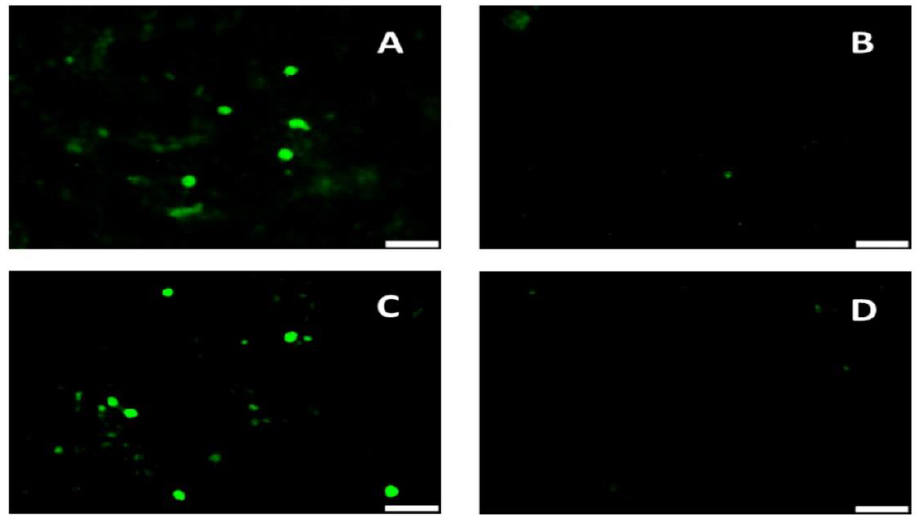
Figure 2. Rescue of the recombinant rPCV2-Vac. ( A ) PK-15 cells transfected with the rPCV2-Vac construct and stained with a PCV2 specific polyclonal antibody ( C ) PK-15 cells transfected with the rPCV2-Vac construct and stained with a Neospora caninum specific polyclonal antibody. ( B ) and ( D ) Un-transfected PK-15 cells stained with the PCV2 or Neospora caninum antibodies respectively. Apple green florescence is indicative of a specific signal. White bar–Scale of 50 µM. Image obtained at 20x magnification.